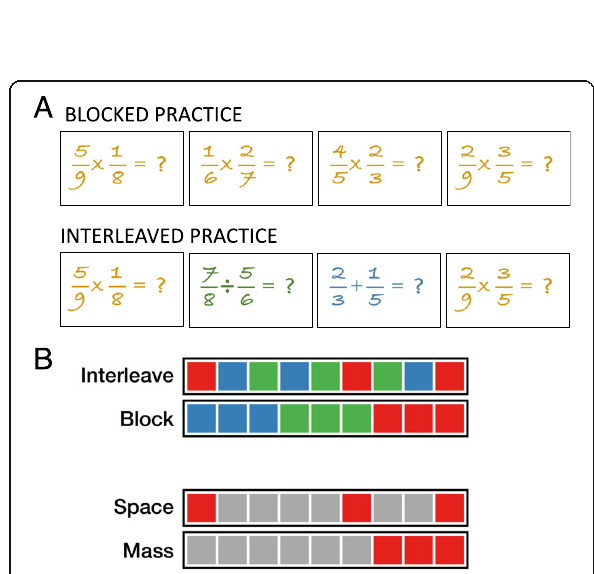
Fig. 2 a Blocked practice and interleaved practice with fraction problems. In the blocked version, students answer four multiplication problems consecutively. In the interleaved